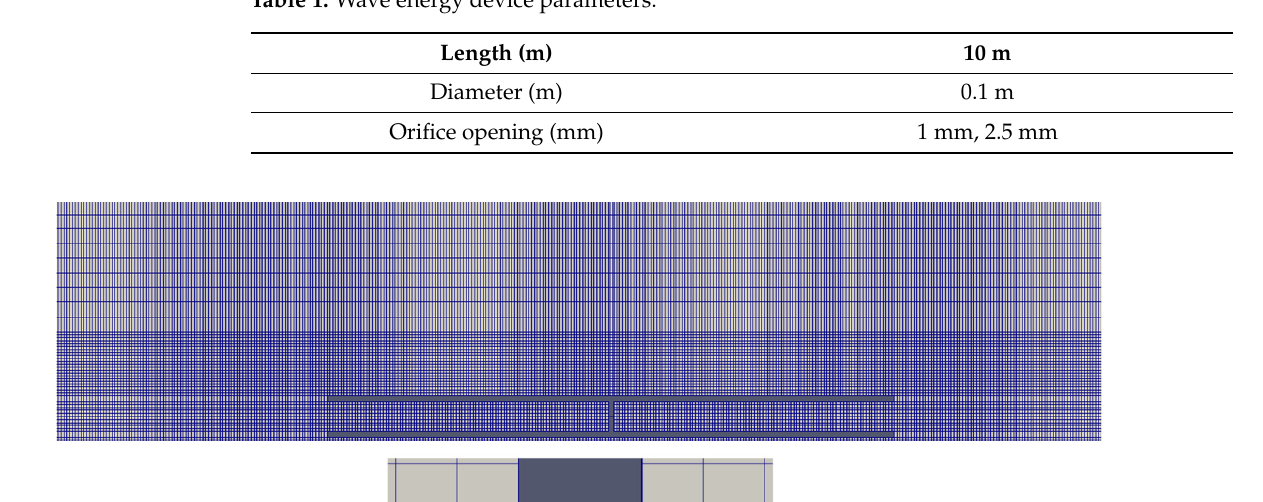
Table 1. Wave energy device parameters.